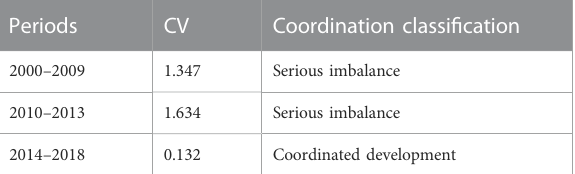
TABLE 4 UCLUC in Hunan Province in different